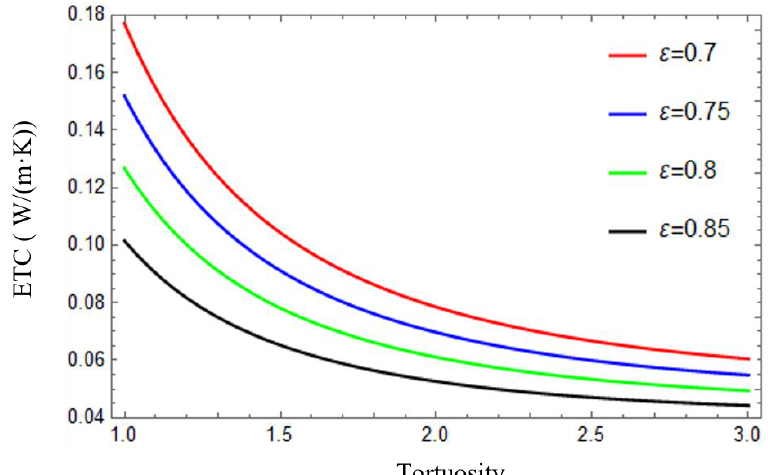
Figure 12. The variation of the ETC with the tortuosity.